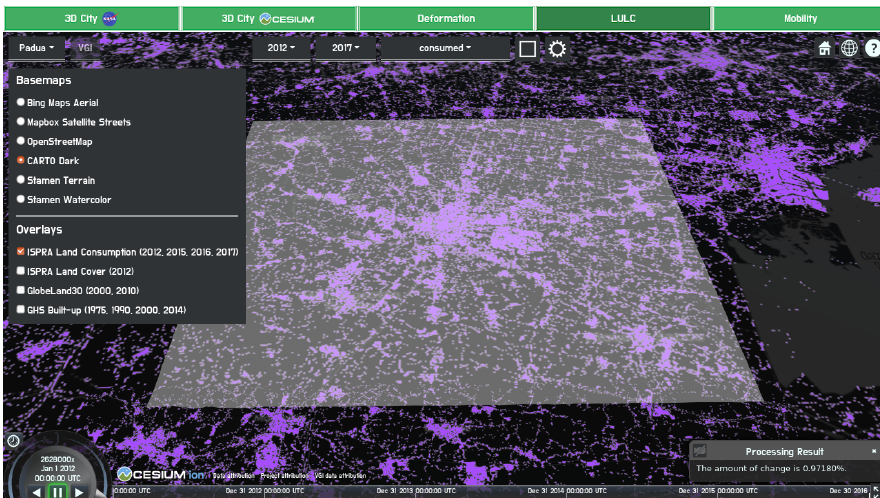
Figure 12. Display of the result of the processing of the drawn area of the land consumption maps from the Italian Institute for Environmental Protection and Research (ISPRA) that calculates the amount of change of consumed areas from 2012 to 2017 on a virtual globe created using